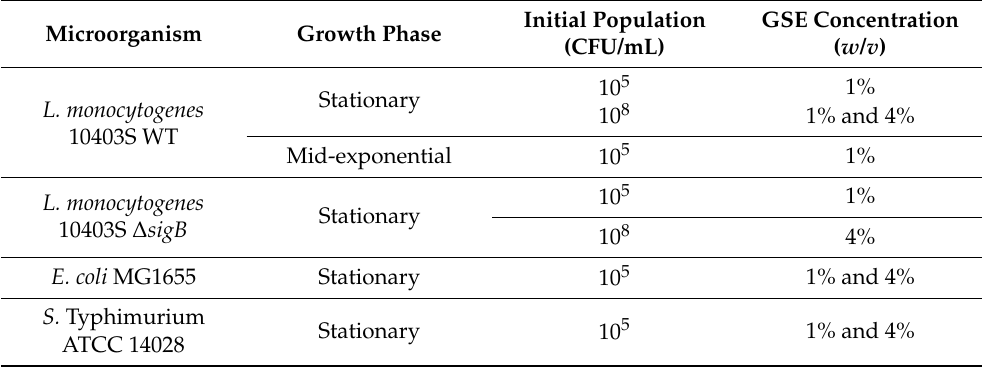
Table 1. Parameters tested in the